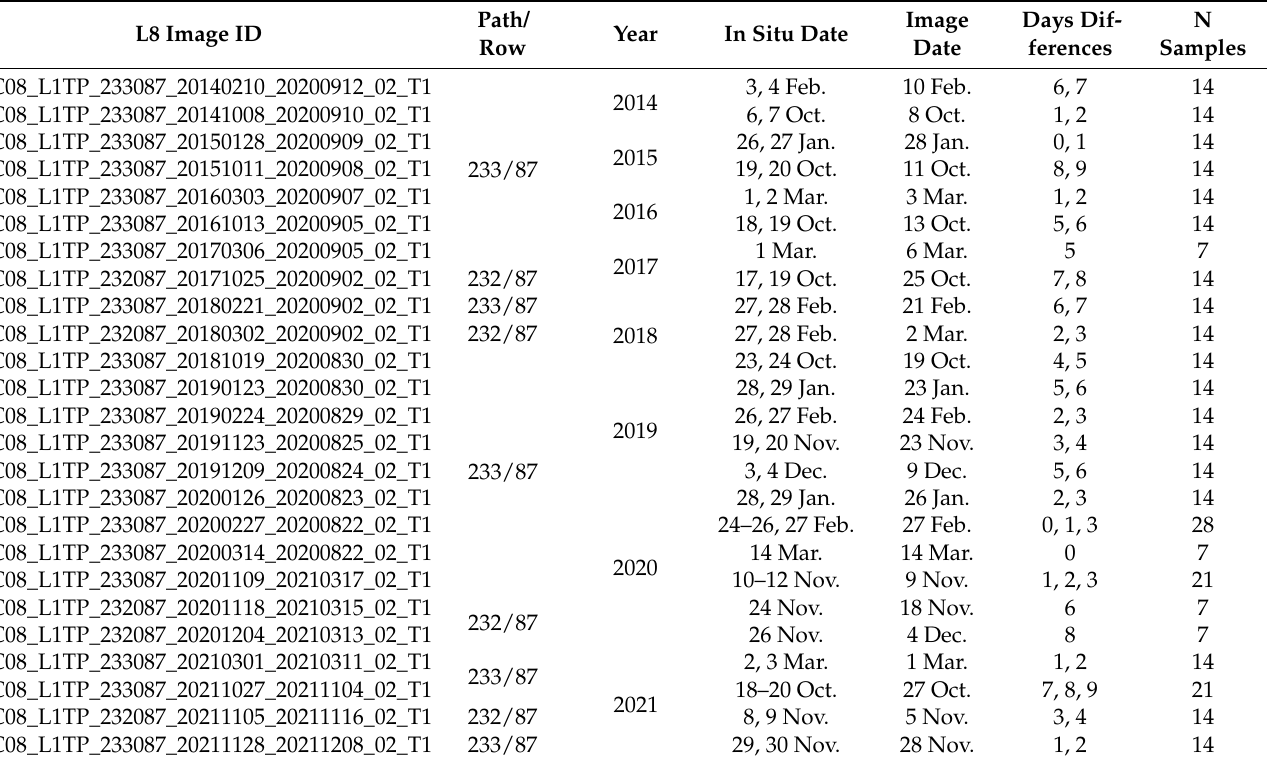
Table 2. Landsat image characteristics and dates of in situ measurements. L8 Image